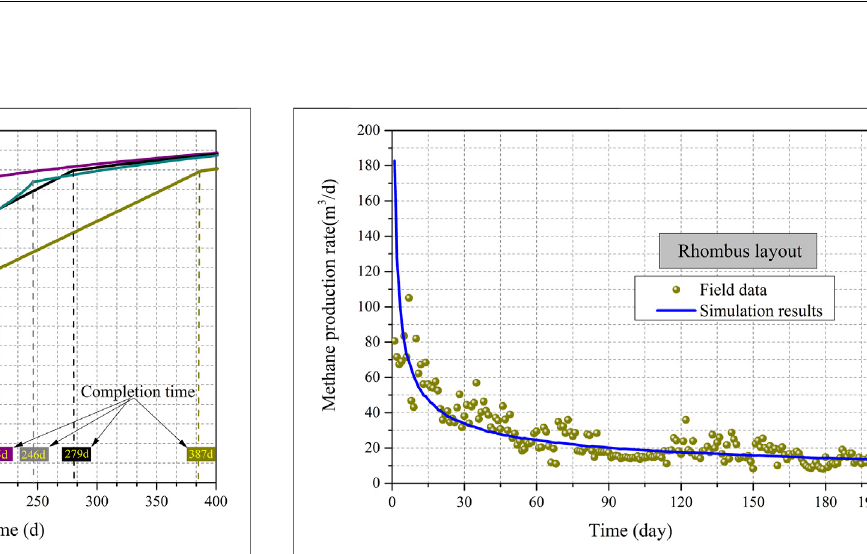
FIGURE 6 | Graph showing effective drainage zone areas vs. drainage time for the four sub-borehole con fi gurations shown in Figures 4 , 5 .